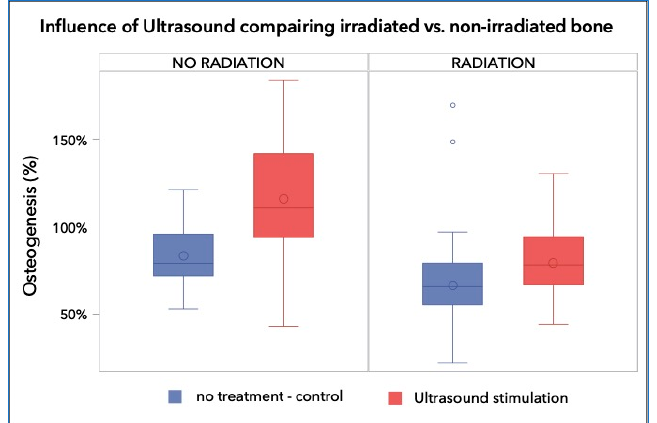
Figure 2. Percentage of the regenerated bone in the defect area of the control group was 83.10% ± 17.79%, whereas those of the irradiated groups reached a bone fill of 66.42% ± 29.36% and 79.21% ± 21.07%, respectively. The non-irradiated and LIPUS treated group achieved 115.91% ± 33.69%, which is a highly significant increase over the control and any irradiated group ( p < 0.001).